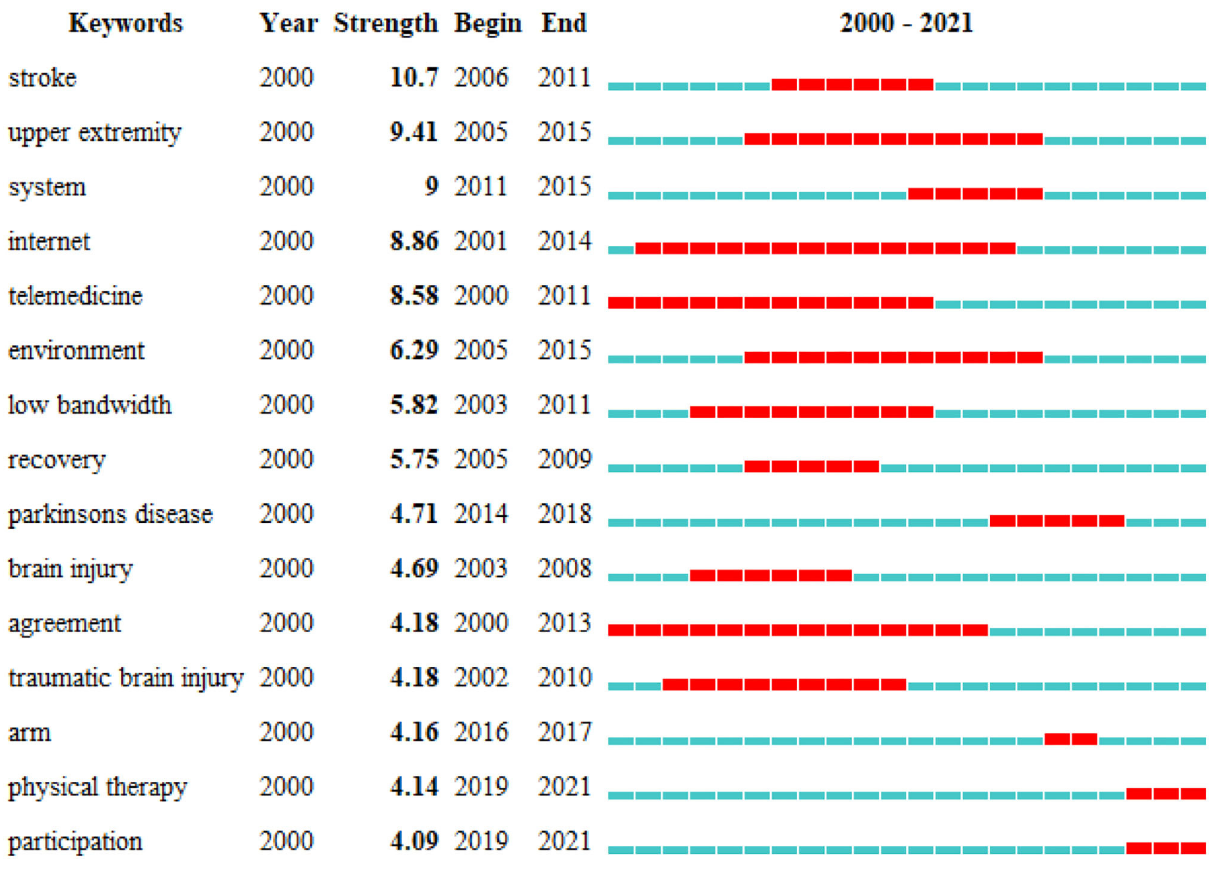
FIGURE 10 | Top 15 keywords with the strongest citation